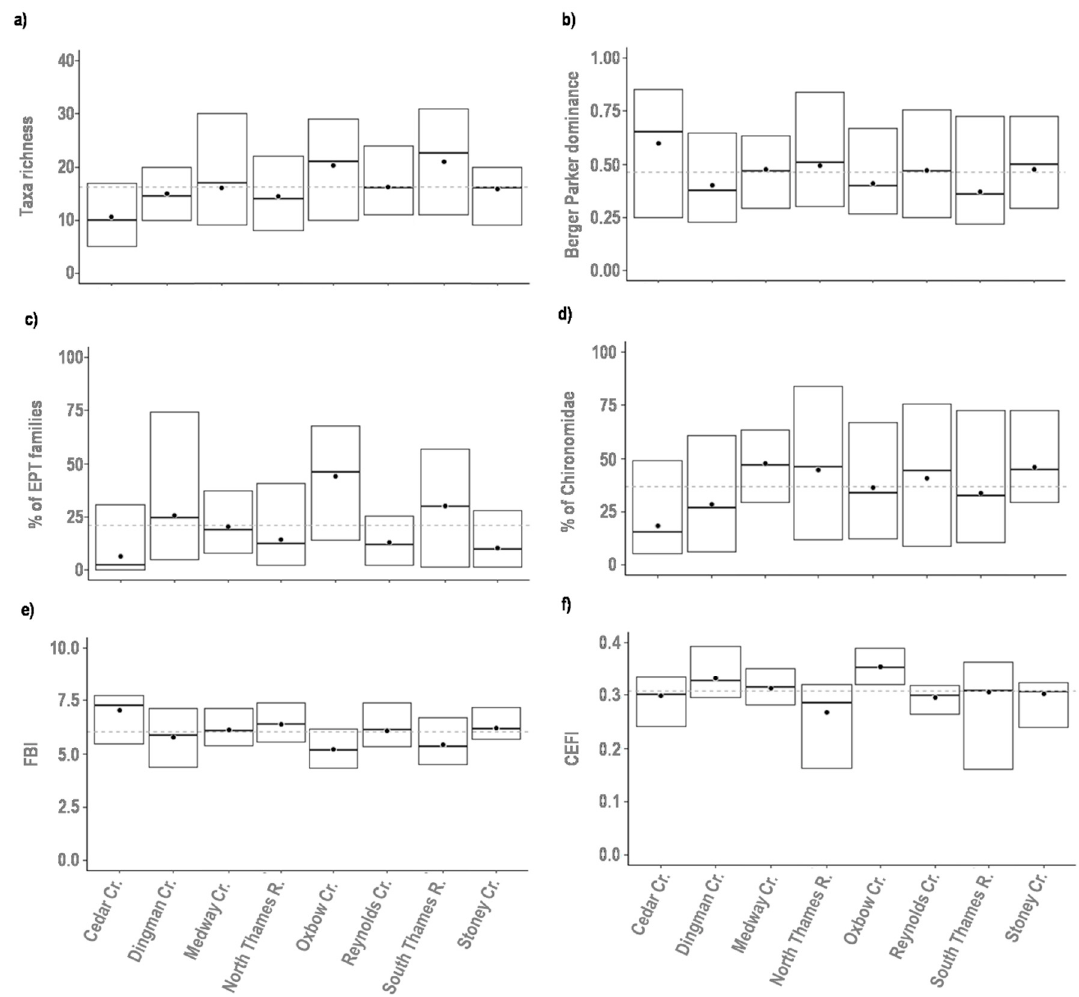
Figure 3. Boxplots of six bioassessment metrics (taxa richness ( a ), Berger Parker dominance ( b ), % of Empheroptera, Plecoptera and Trichoptera (EPT) families ( c ), % of Chironomidae ( d ), Family Biotic Index (FBI) ( e ), and Canadian Ecological Flow Index (CEFI) ( f )) summarizing benthic macroinvertebrate communities for eight rivers in the Upper Thames River Basin (southern Ontario, Canada) monitored for at least 14 years. Bars represent range of values, solid black lines represent median values, and black circles represent means. Gray dashed line indicates mean of all streams combined.